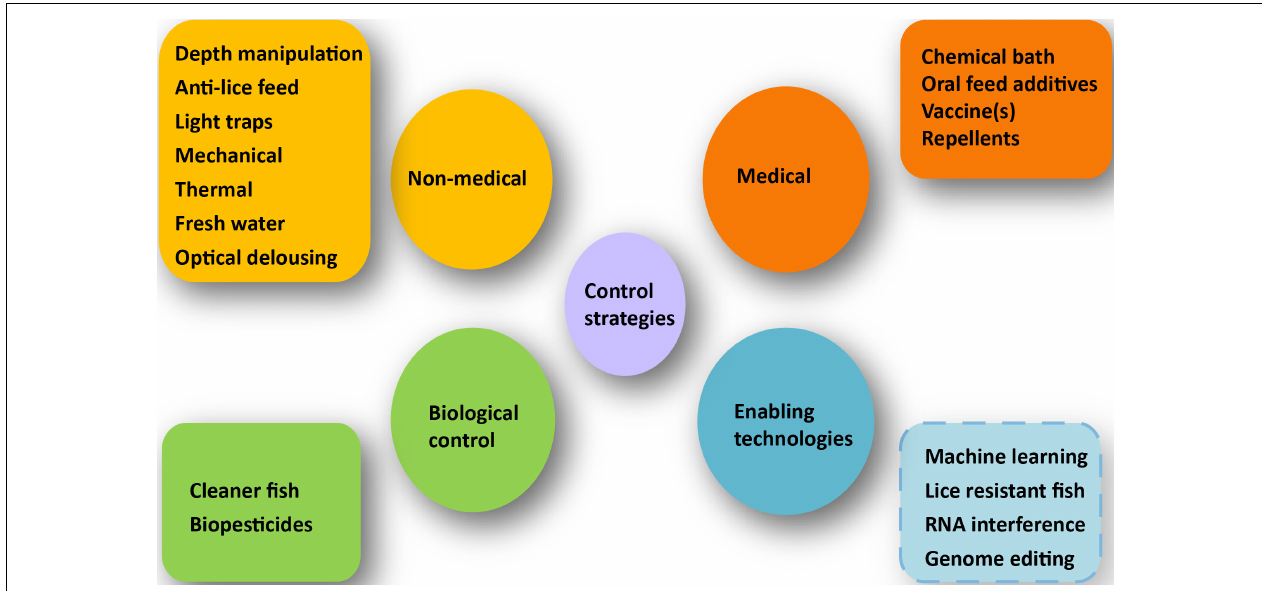
FIGURE 1 | Various control strategies for salmon lice management. The figure displays an overview of recent scientific advances, as well as methods and strategies for combating salmon lice, discussed in the text. The dotted blue box depicts the technologies that are still in the developing phase but might have a big influence on salmon lice management in the